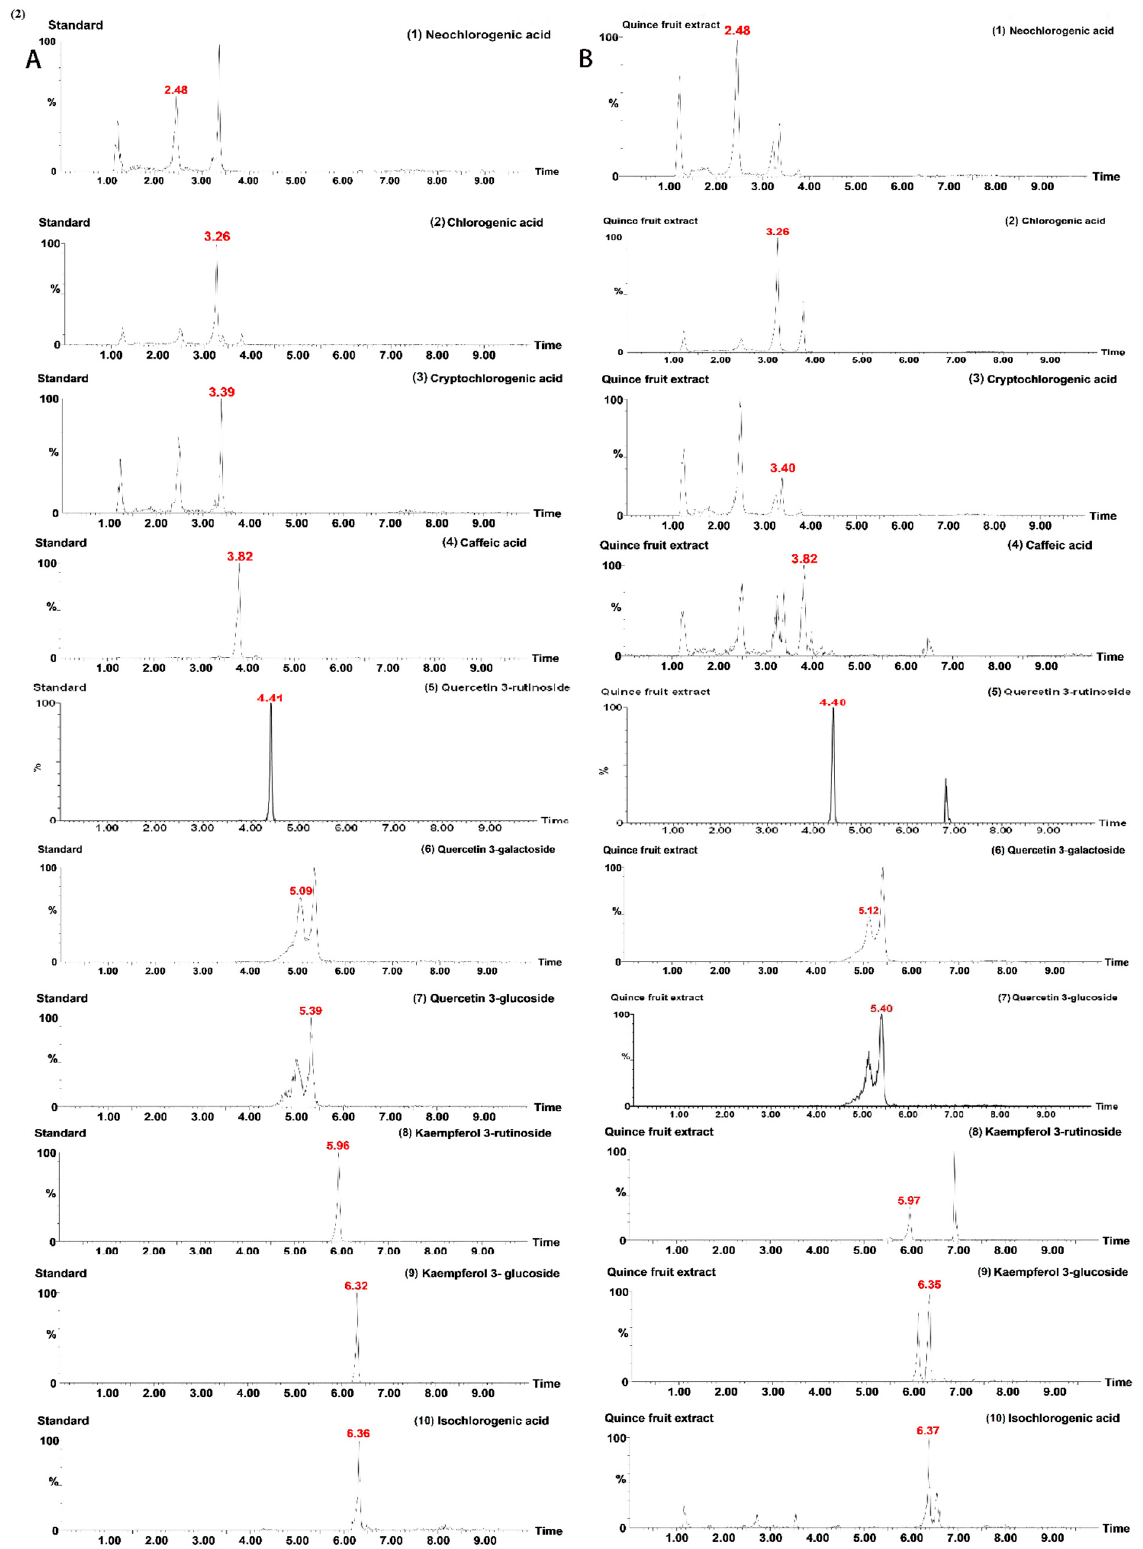
Figure 3. Typical MRM chromatograms of ( A ) standards, ( B ) extract: (1) Neochlorogenic acid, (2) Chlorogenic acid, (3) Cryptochlorogenic acid, (4) Caffeic acid, (5) Quercetin 3-rutinoside, (6) Quercetin 3-galactoside, (7) Quercetin 3-glucoside, (8) Kaempferol 3-rutinoside, (9) Kaempferol 3-glucoside, and (10) Isochlorogenic acid.